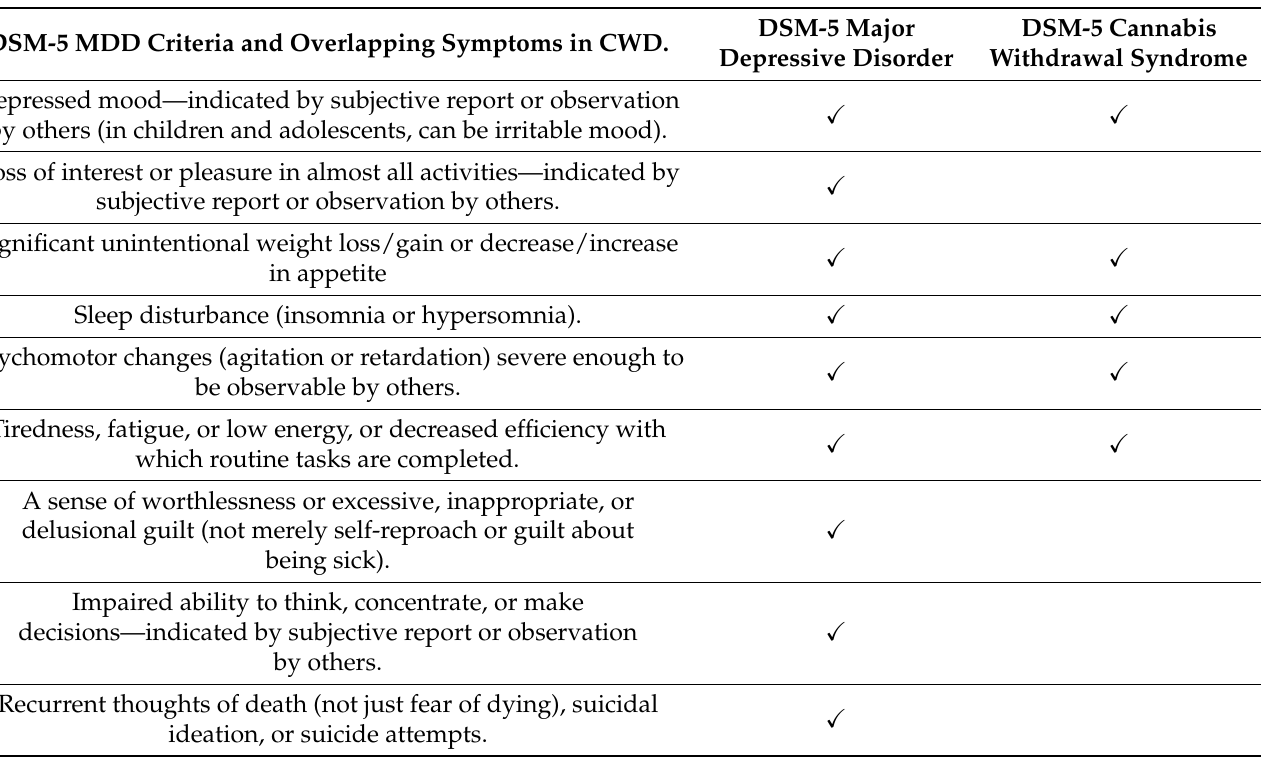
Table 2. DSM-5 Major Depressive Disorder criteria, and overlapping cannabis withdrawal symptoms. DSM-5 MDD Criteria and Overlapping Symptoms in